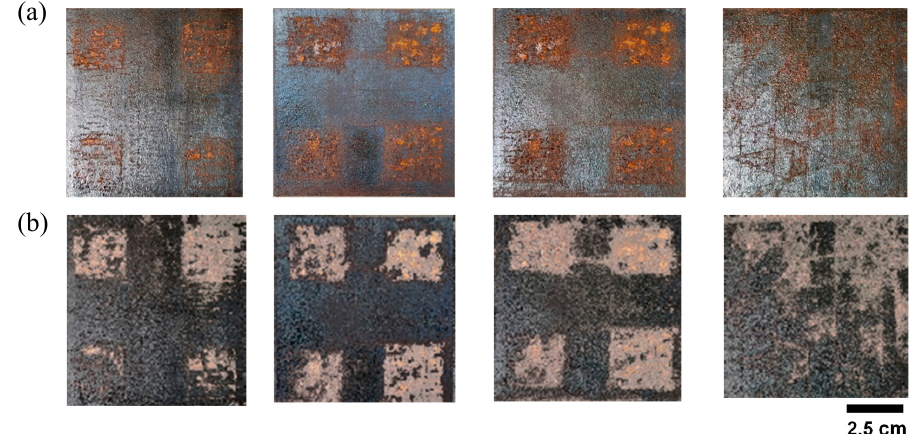
Figure 10. Test images of partially corroded steel plates wetted in oil and acquired in natural daylight. ( a ) ground truth images, ( b ) MLP-based corrosion prediction.